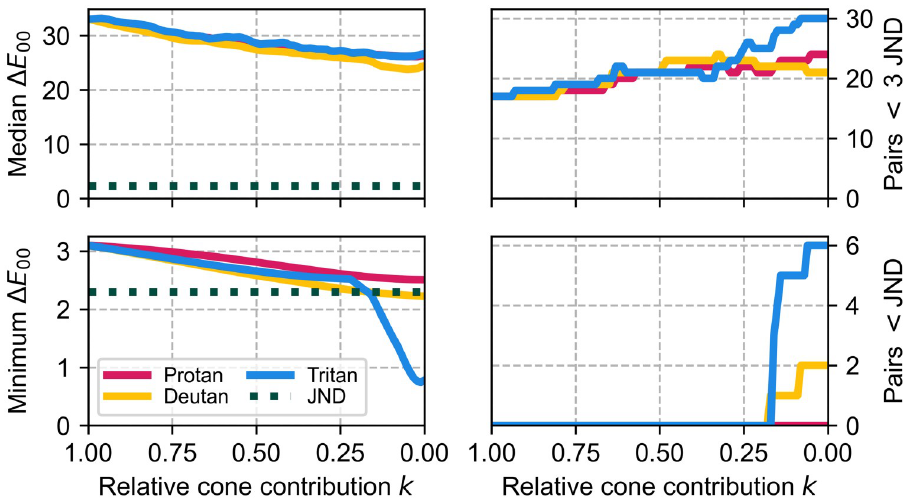
Fig 5. Discriminability of Forel-Ule colours. The median and minimum (left) Δ E 00 difference between FU colour pairs, and the number of pairs within 3 and 1 JND (right), are shown as a function of the relative cone contribution k . k ranges from 1 (full colour vision) to 0 (dichromacy), with intermediate values representing partial colour blindness (anomalous trichromacy). Pairs with Δ E 00 < 1 JND are fully indistinguishable, pairs with < 3 JND are difficult to distinguish (Section